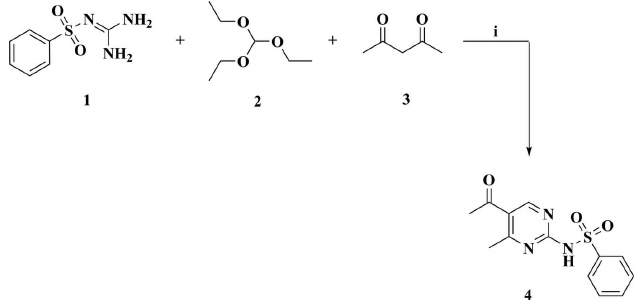
Figure 4 The synthesis of the title compound ( 4 ). Reagents & Conditions: (i) reflux; 6